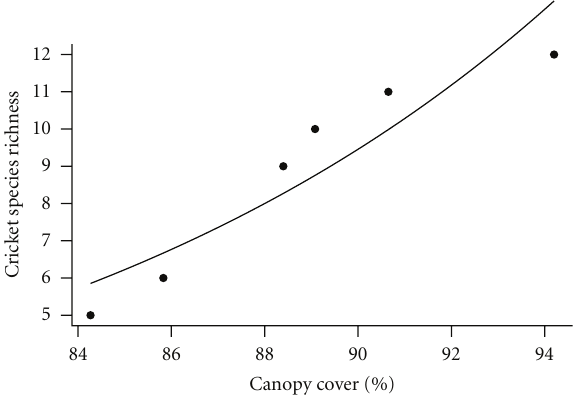
Figure 3: Response of cricket species richness to canopy cover. Species richness increased linearly with canopy cover. Linear regression with Poisson’s errors: y = e ( − 5 . 285+0 . 083 ∗ x ) ; χ 2 = 3.97; P = 0 . 046.